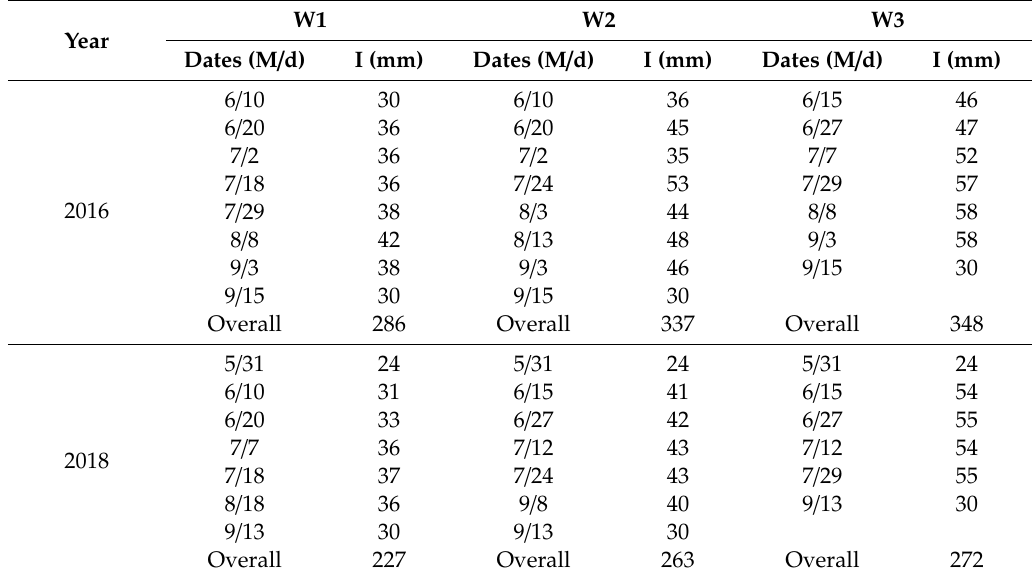
Table 2. Irrigation timing and amount during the growing season for spring maize in 2016 and